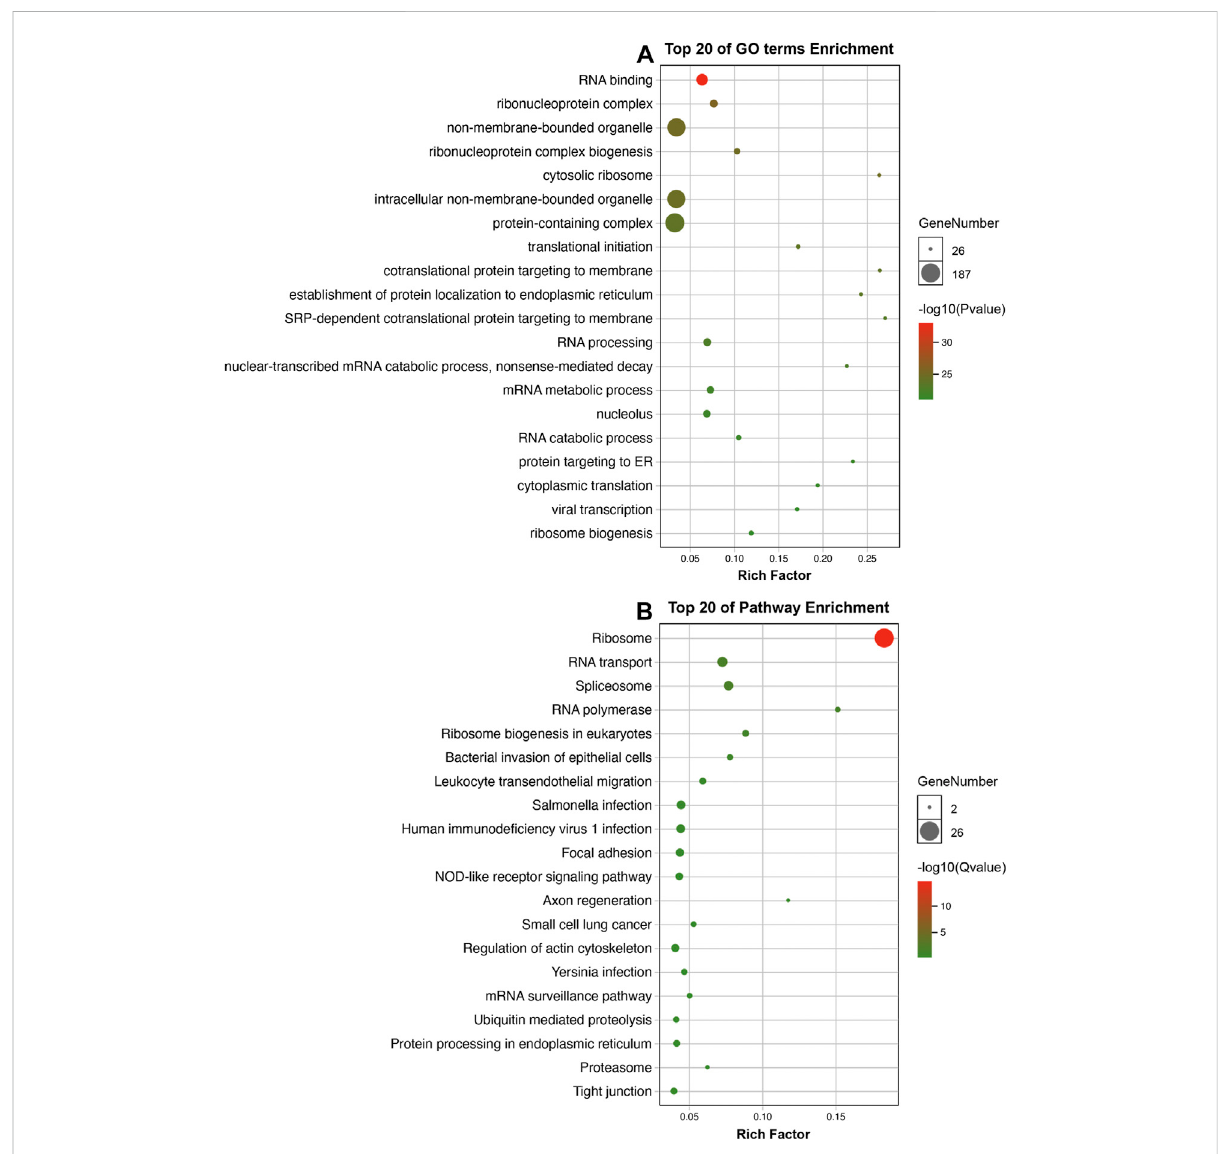
FIGURE 6 Enrichment analysis. (A) GO analysis of LLPS-related genes; (B) KEGG analysis of LLPS-related